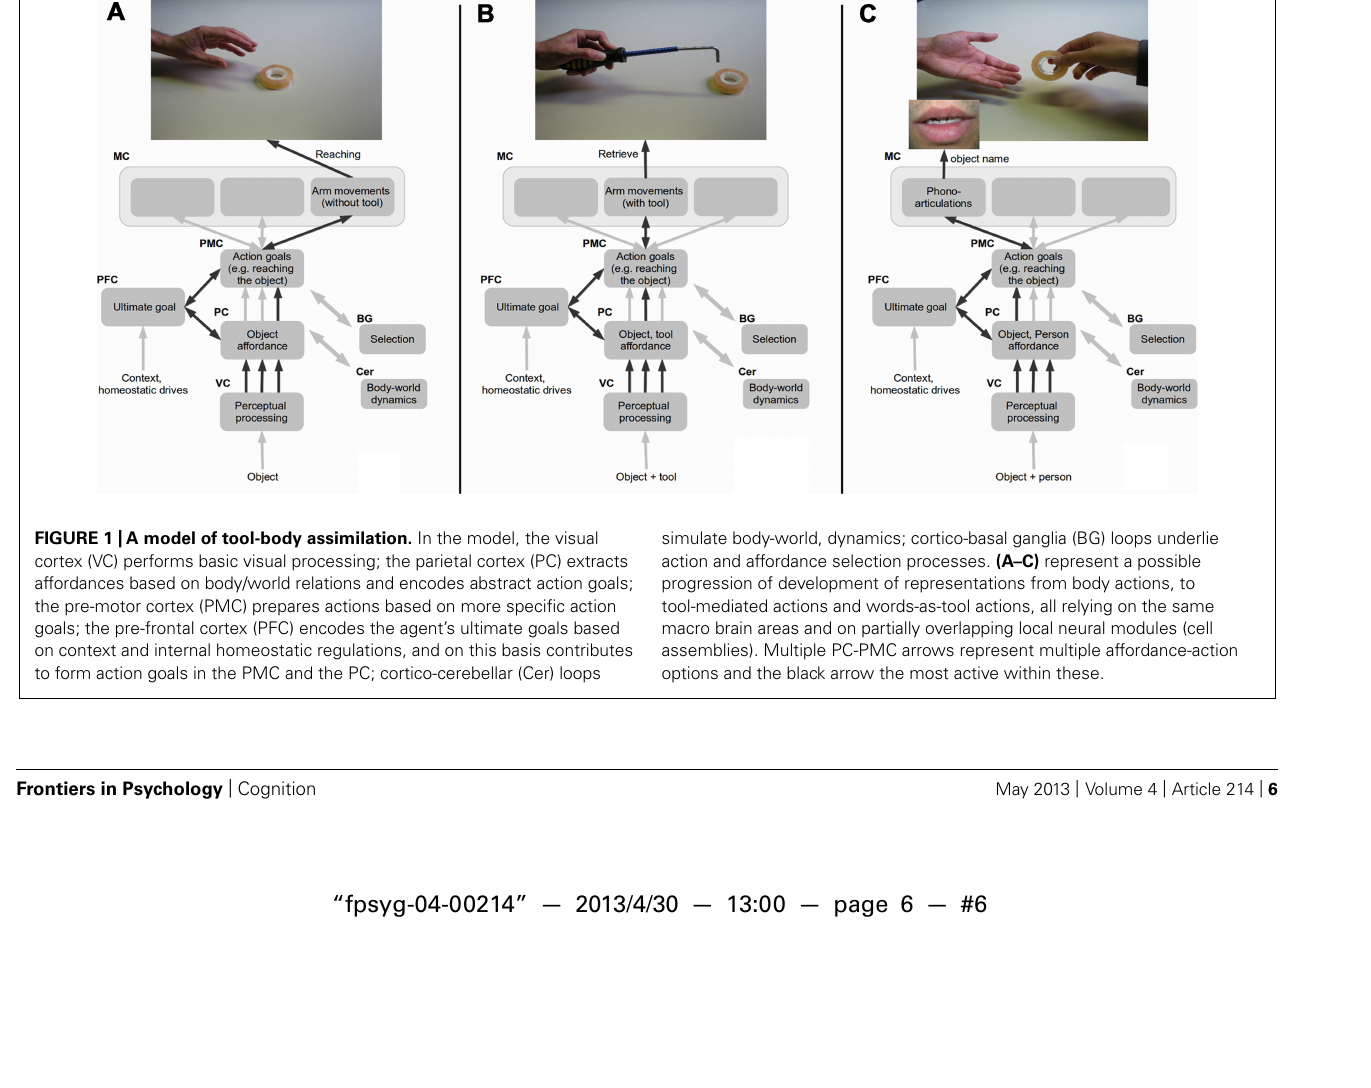
FIGURE 1 |A model of tool-body assimilation. In the model, the visual cortex (VC) performs basic visual processing; the parietal cortex (PC) extracts affordances based on body/world relations and encodes abstract action goals; the pre-motor cortex (PMC) prepares actions based on more specific action goals; the pre-frontal cortex (PFC) encodes the agent’s ultimate goals based on context and internal homeostatic regulations, and on this basis contributes to form action goals in the PMC and the PC; cortico-cerebellar (Cer) loops